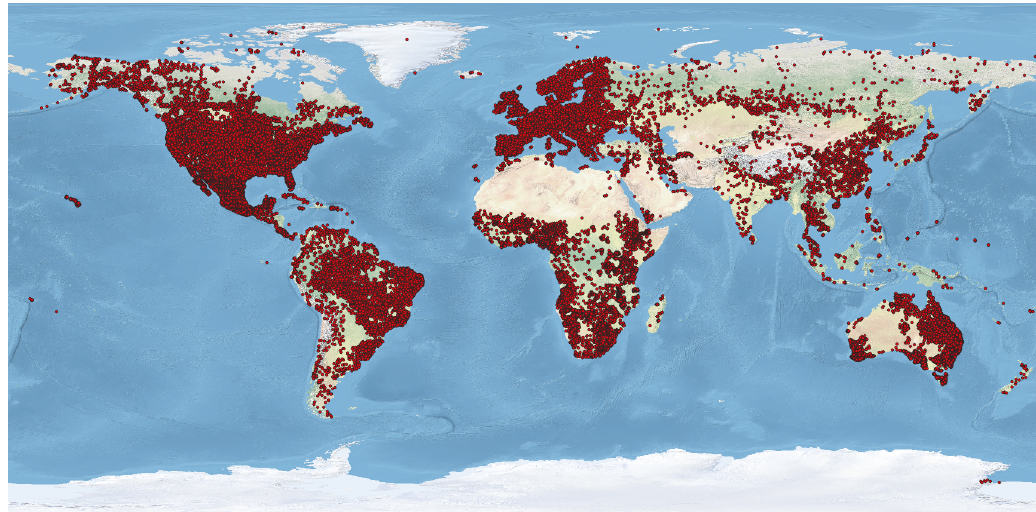
Figure 2. Location of soil profiles provided in the “September 2019” snapshot of WoSIS; see Appendix C for the number and density of profiles by